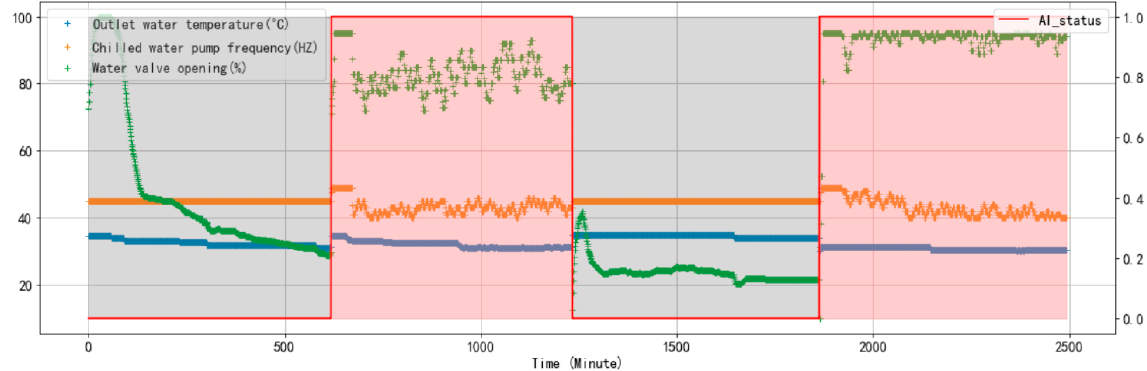
Figure 11. Action trends of AB tests (the grey area represents the AI_status is 0, the red area represents the AI_status is 1).